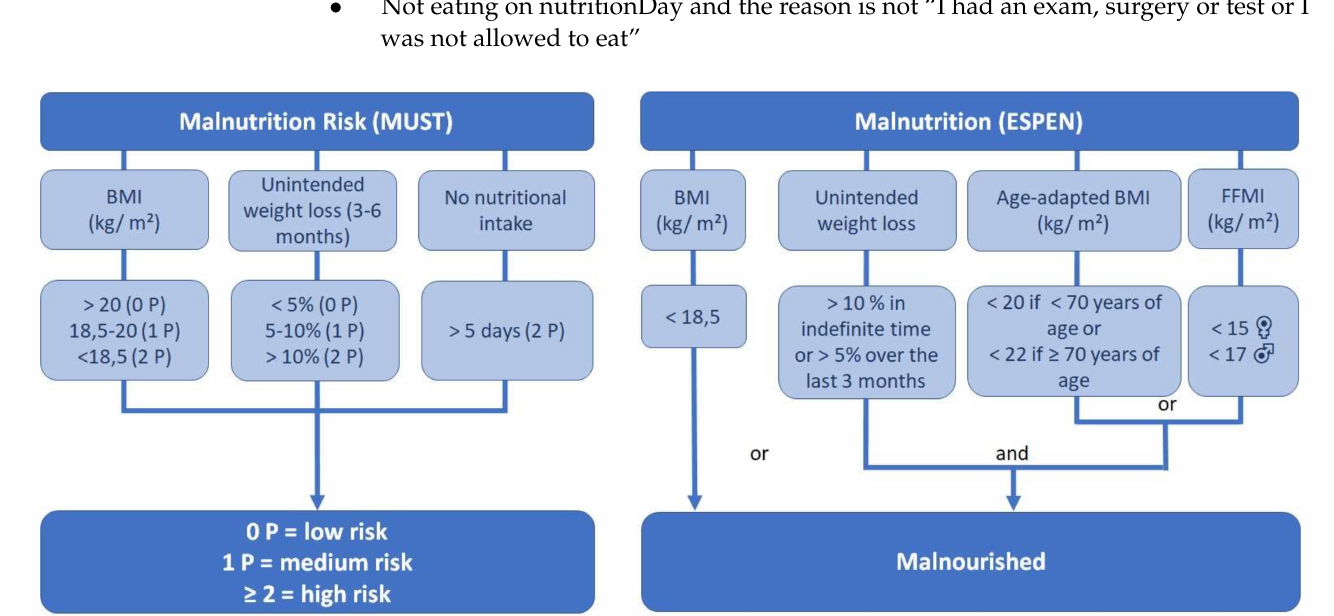
Figure 1. Malnutrition risk and Malnutrition